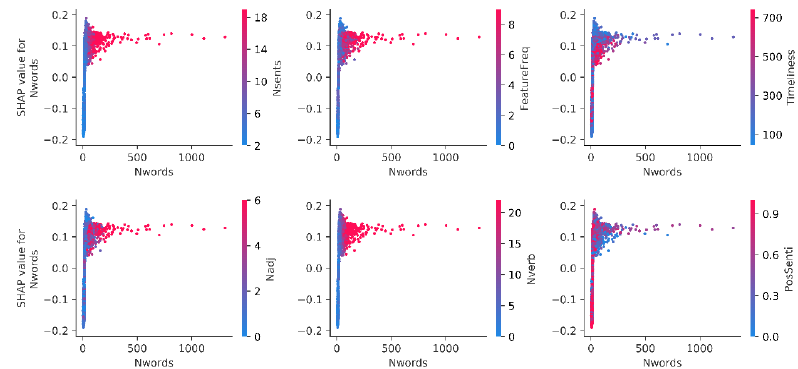
Figure 7. Individual joint feature contribution on the headset dataset. (Source of data: https://www.amazon.cn).